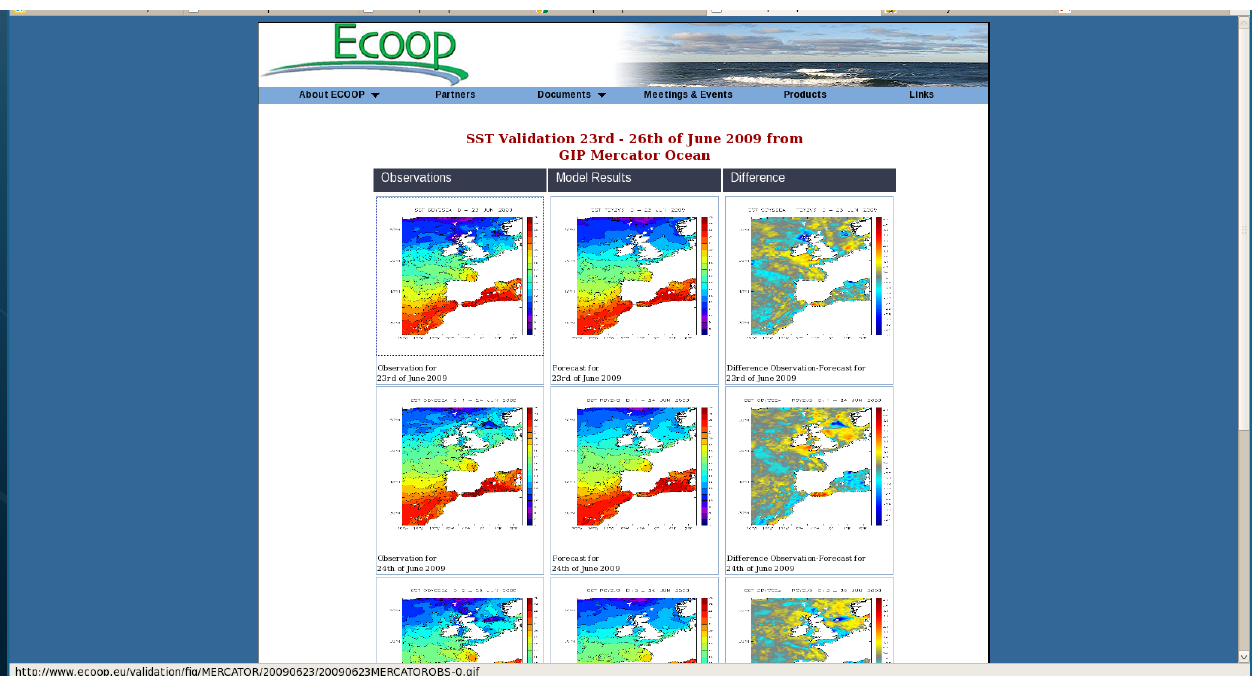
Figure 4 : ECOOP Validation webpage : e.g. for IBI regional system. Fig. 4. ECOOP Validation webpage: e.g. for IBI regional